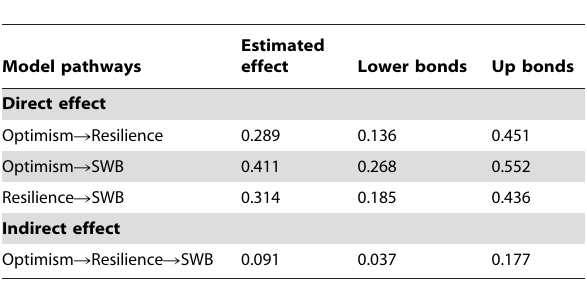
Table 2. Direct and indirect effects and 95% confidence intervals for the final